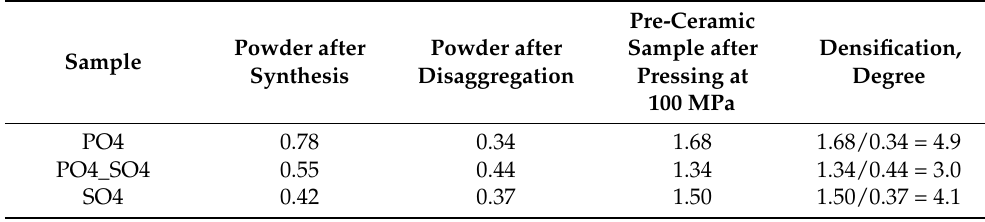
Table 4. Bulk density of powders after synthesis and disaggregation in acetone, as well as the density of samples after pressing at 100 MPa (g/cm 3